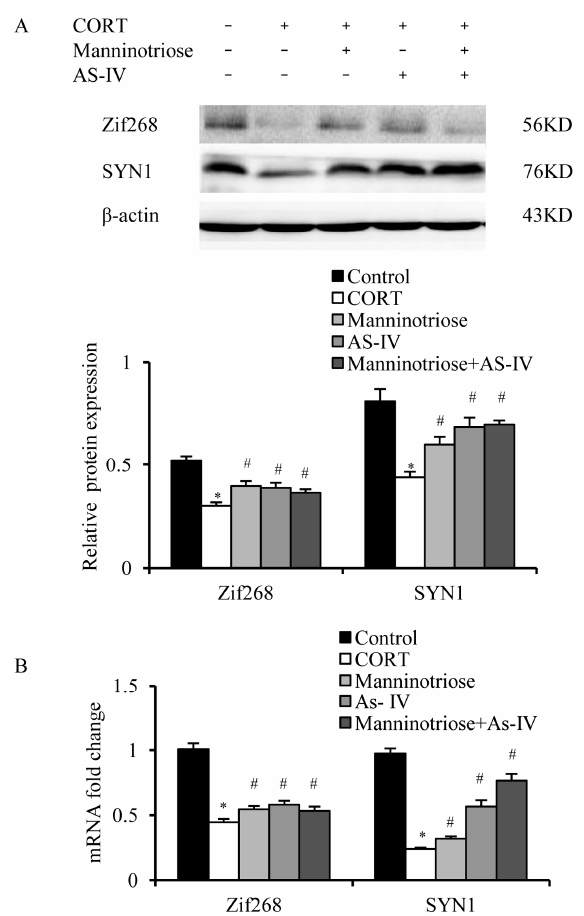
Figure 4. Effects of Manninotriose and AS-IV on the expression of SYN1 and Zif268 gene in CORT injured hippocampal neurons. ( A ) SYN1 and Zif268 expression assessed by western blot analysis. ( B ) Effect of Manninotriose and AS-IV on SYN1 and Zif268 mRNA expression in CORT-injured hippocampal neurons as determined by qRT-PCR. Data are presented as the mean ± SD ( n = 3). * p < 0.05 vs. control group; # p < 0.05 vs. CORT group.